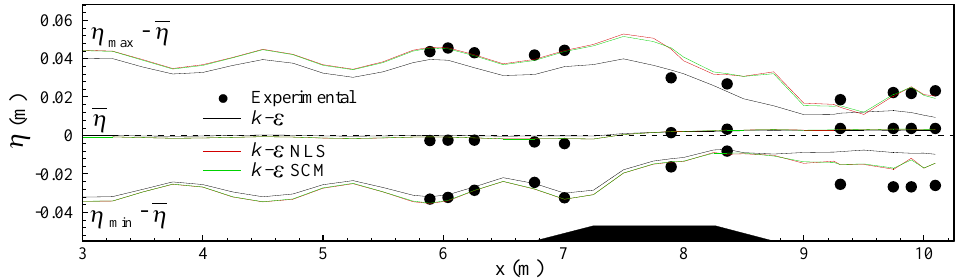
Figure 16. Maximum and minimum wave height envelopes and mean water level of k- ε , k- ε NLS and k- ε SCM models and the experiment (dash line indicates the still water level), T = 1.6 s, H = 0.07 m.